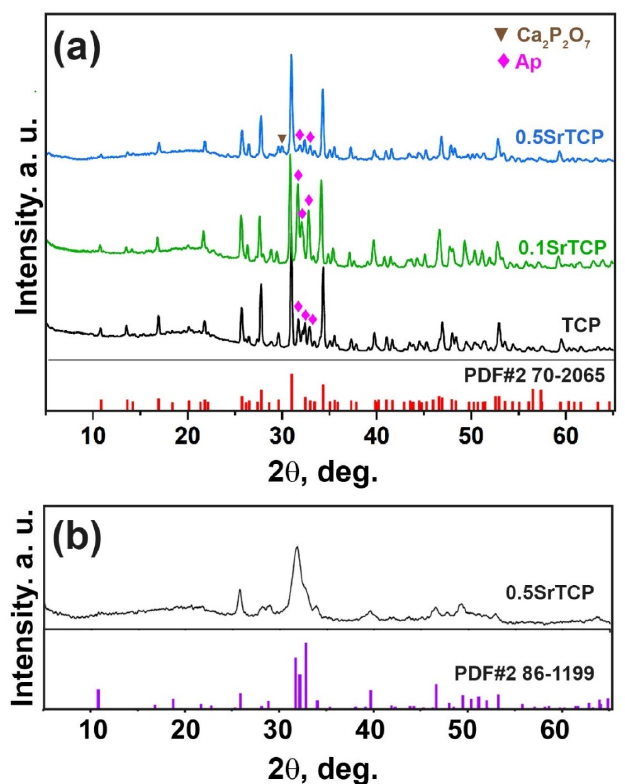
Figure 1. ( a ) PXRD patterns of TCP, 0.1SrTCP, and 0.5SrTCP powders along with PDF#2 card 70-2065 ( β -Ca 3 (PO 4 ) 2 ) as a reference. The impurities of the Ap-type phase and calcium pyrophosphate (Ca 2 P 2 O 7 ) are labeled. ( b ) PXRD pattern of 0.5SrTCP powder preheated at 400 °C.